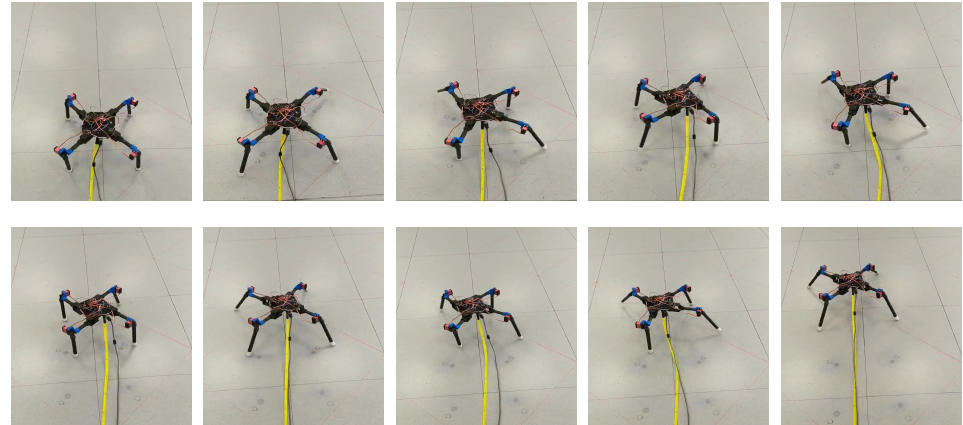
Figure 2. Snapshots of the Ant robot walking on the marked arena within 12 s with PSTO and leg length of 1 L (23 cm). The side length of each black square on the ground is 1